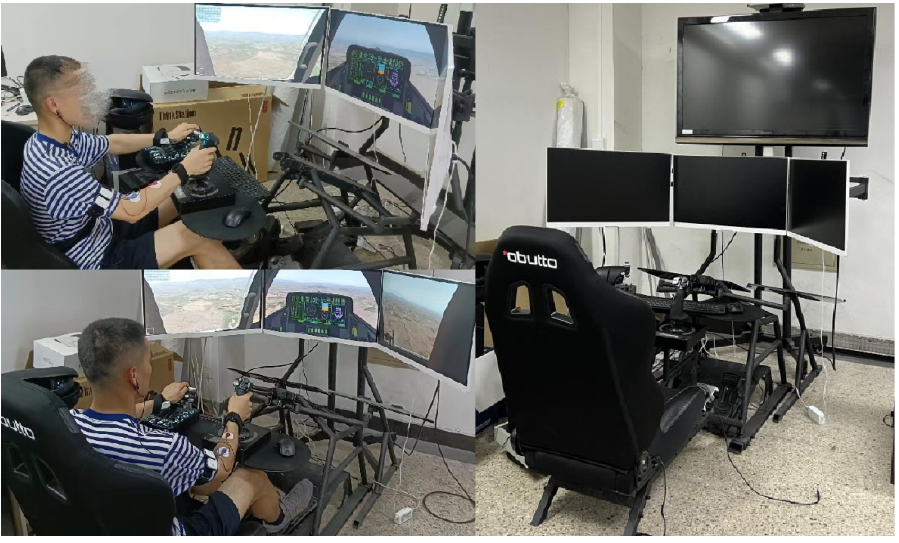
Figure 2. Illustration of the experimental platform.